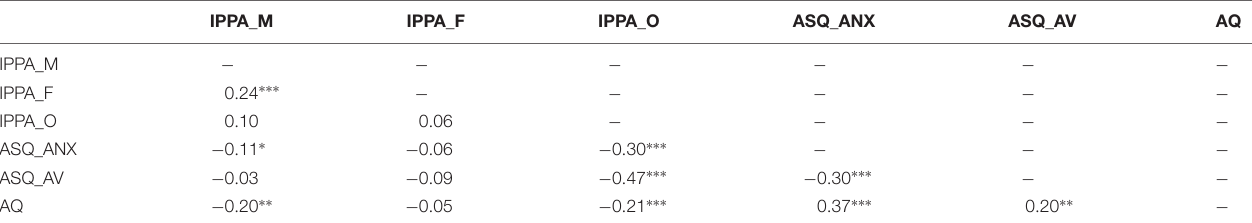
TABLE 3 | Correlations of the parent and peer attachment (IPPA), anxiety and avoidance dimensions of attachment style questionnaire (ASQ) and aggression questionnaire (AQ) for female b